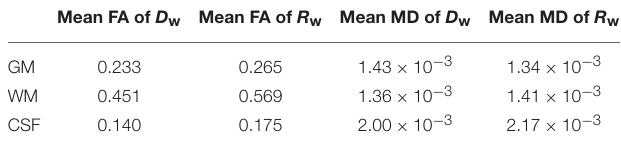
TABLE 2 | Mean FA and MD for GM, WM, and CSF for D w and for R w